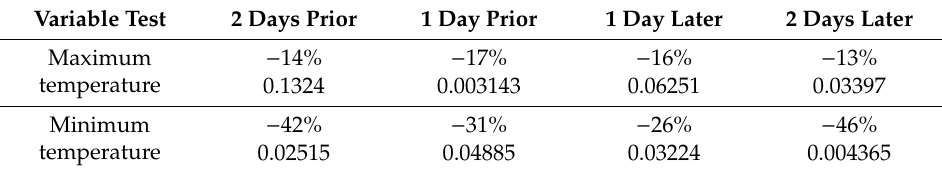
Table 2. 5-day interval temperature change test for likely rain-on-snow events